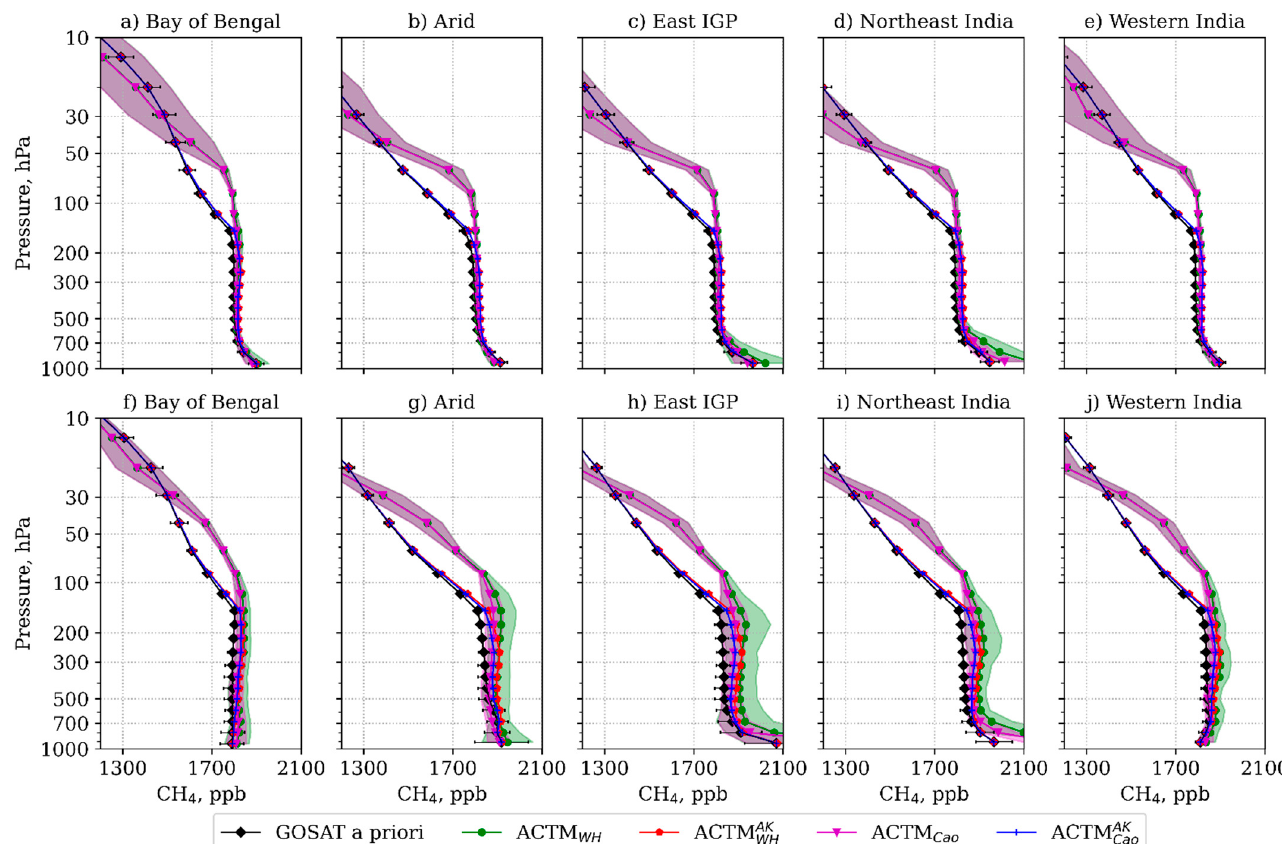
Figure 9. Seasonal mean CH 4 vertical profiles ( a – e ) for winter (January–March) and ( f – j ) monsoon (July–September) periods of 2011 are shown for the selected regions. Black line shows the GOSAT-TIR a priori data. Green and magenta lines with shaded areas correspond to the ACTM Cao and ACTM WH data with 1- σ SD uncertainty, respectively. Red and blue lines represent the CH 4 from ACTM (cid:2887)(cid:2911)(cid:2925) (cid:2885)(cid:2895) and ACTM (cid:2907)(cid:2892) (cid:2885)(cid:2895) smoothed with the AK functions implementation.